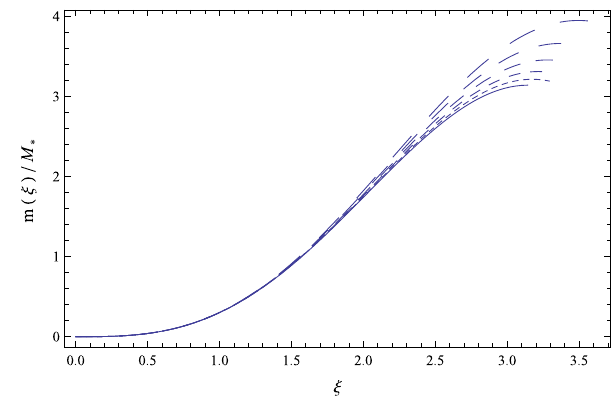
Fig. 2 Variationofthedimensionlessratio m (ξ)/ M ∗ , M ∗ = 4 πρ c / k 3 , as a function of ξ = kr for a rotating Bose–Einstein condensate dark matter halo for different values of (cid:14) 2 : (cid:14) 2 = 0 (solid curve), (cid:14) 2 = 0 . 01 (dotted curve), (cid:14) 2 = 0 . 0225 (short dashed curve), (cid:14) 2 = 0 . 04 (dashed curve), (cid:14) 2 = 0 . 0625 (long dashed curve), and (cid:14) 2 = 0 . 09 (ultra-long dashed curve),